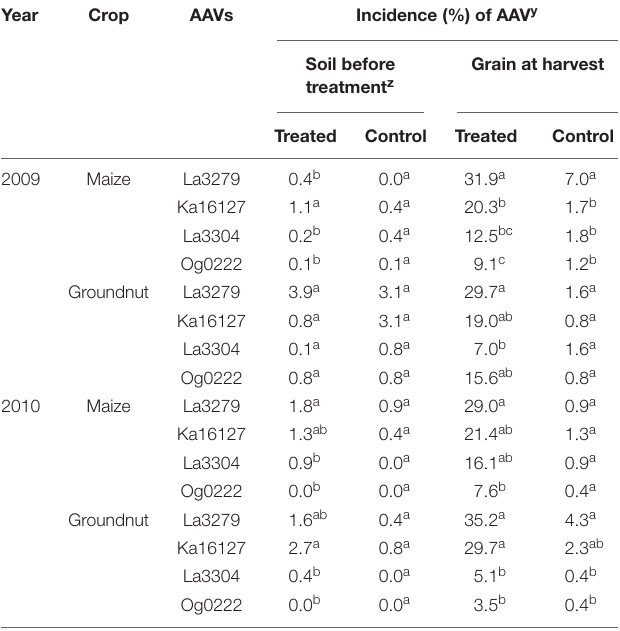
TABLE 5 | Incidence (%) of the four atoxigenic African Aspergillus flavus vegetative compatibility groups (AAVs) constituting an aflatoxin biocontrol product in soil before its application and in maize and groundnut grains from treated and control fields during 2009 and 2010.